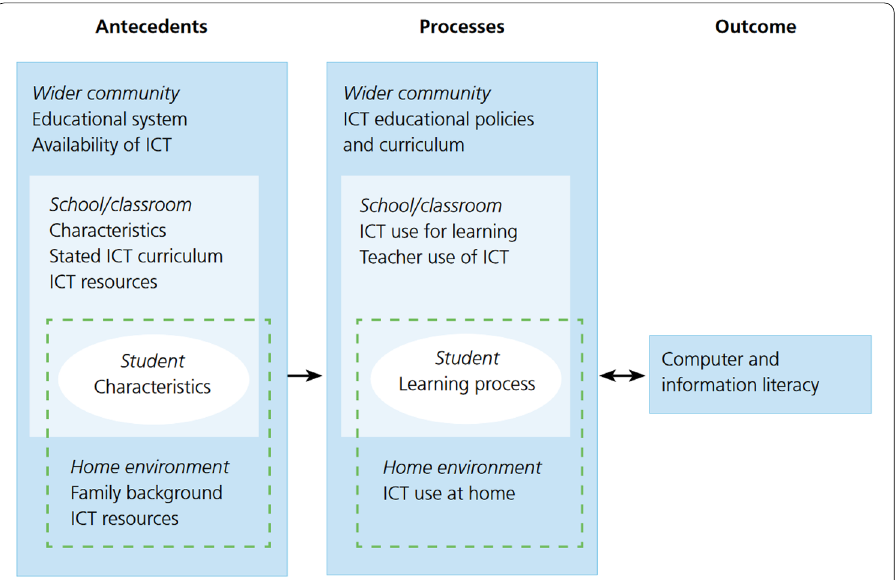
Fig. 1 ICILS 2013 Framework Model (Fraillon et al.